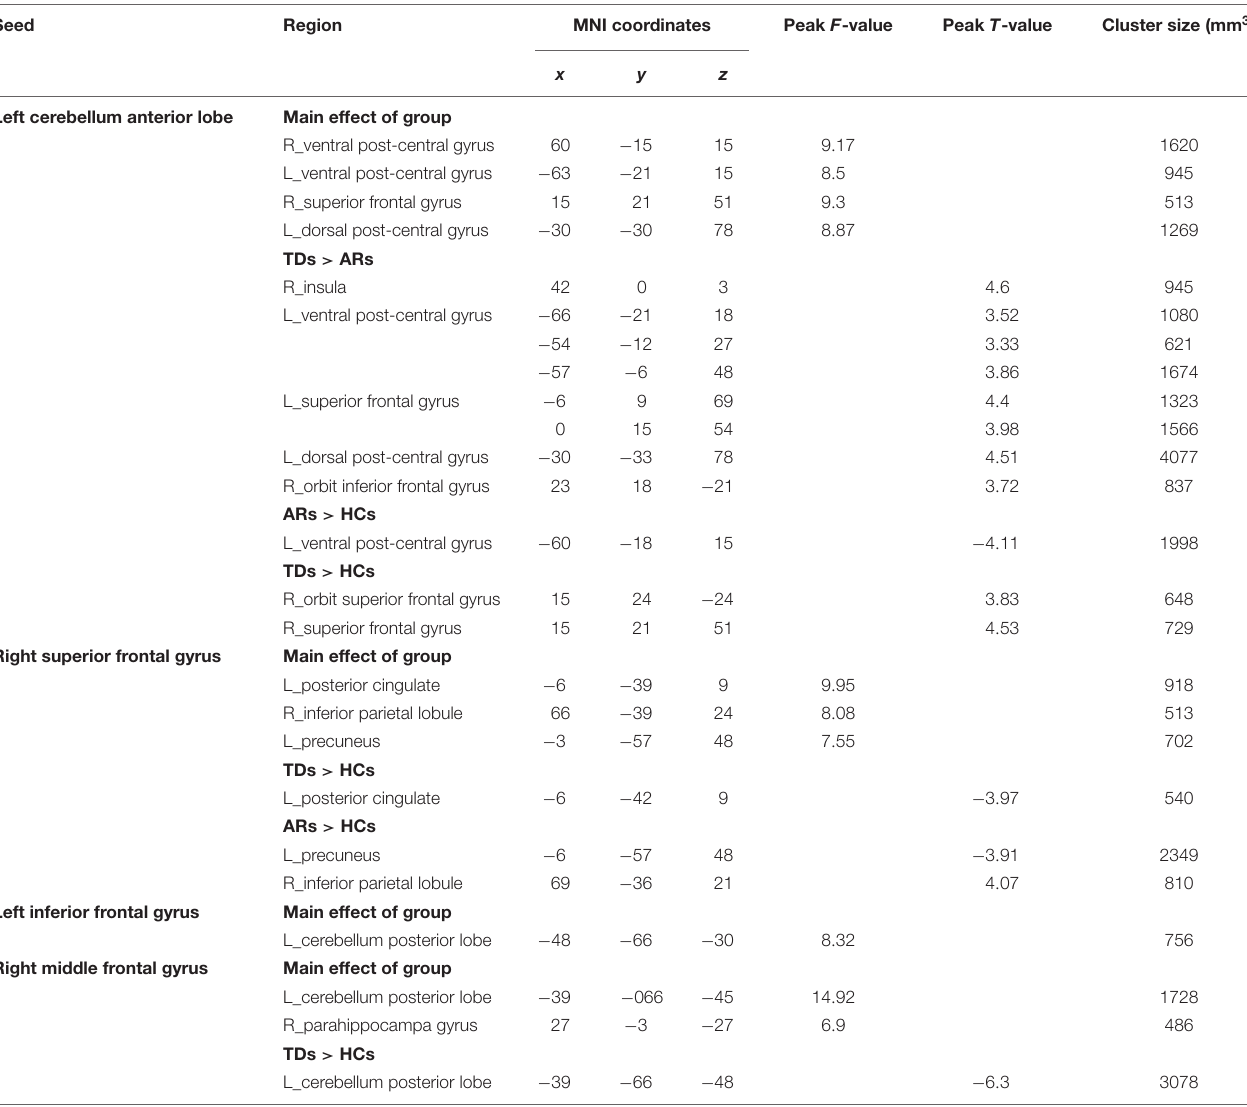
TABLE 4 | The altered functional connections of seeds in the group level. Seed Region MNI coordinates